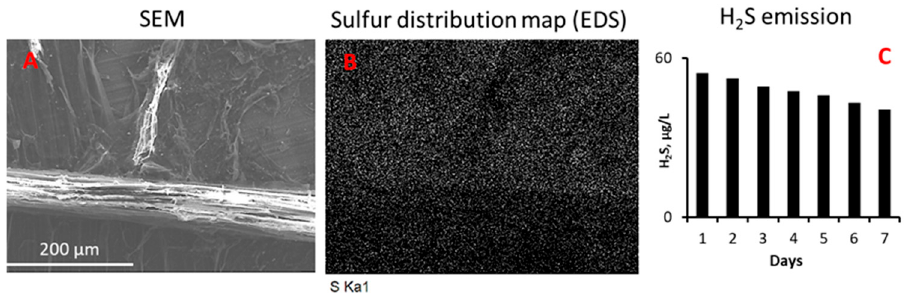
Figure 6. ( A ) SEM image of birch root sample homogenate (1.5 µ g/L TiS 3 -exposed group), ( B ) EDS sulfur distribution map, ( C ) emission of hydrogen sulfide from titanium trisulfide nanoribbons in bidistilled water for 7 days.